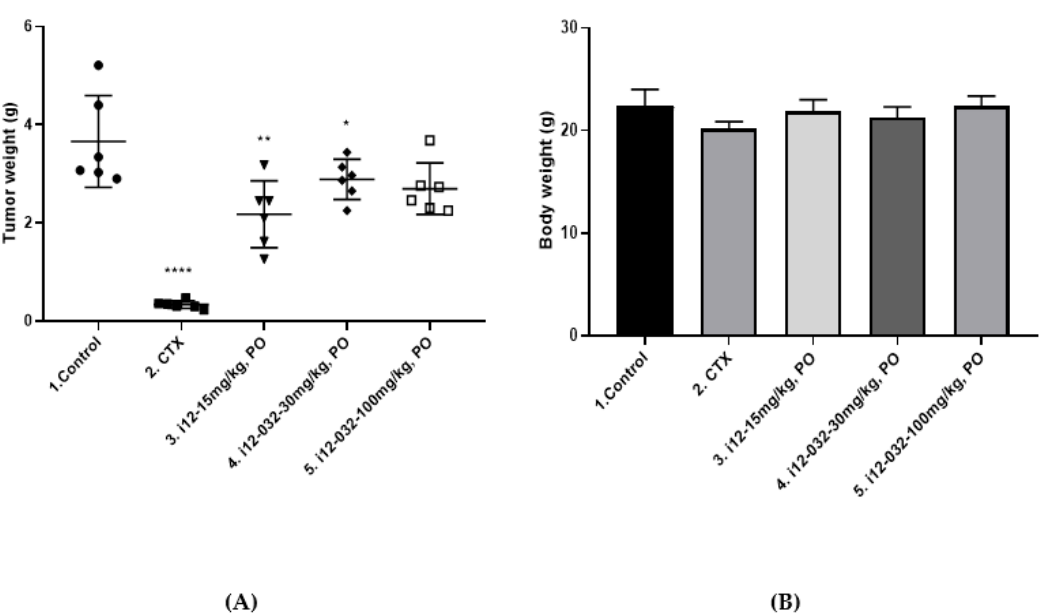
Figure 4. In vivo anti-tumor activity of i12 in B16F10 xenograft mice. ( A ) Tumor weights of each group after 17 days of treatment. The control group mice bearing B16F10 xenografts were dosed orally with vehicle (0.5% sodium salt of carboxymethyl cellulose, CMC-Na); the CTX group were administered CTX intraperitoneally at the dose of 100 mg / kg; the treated group were administered i12 orally at the dose of 15, 30 or 100 mg / kg. * p < 0.05, ** p < 0.01 and **** p < 0.0001 versus vehicle. ( B ) The body weight of each group after the treatment. There is no obvious body weight difference among all of the i12 -treated groups.